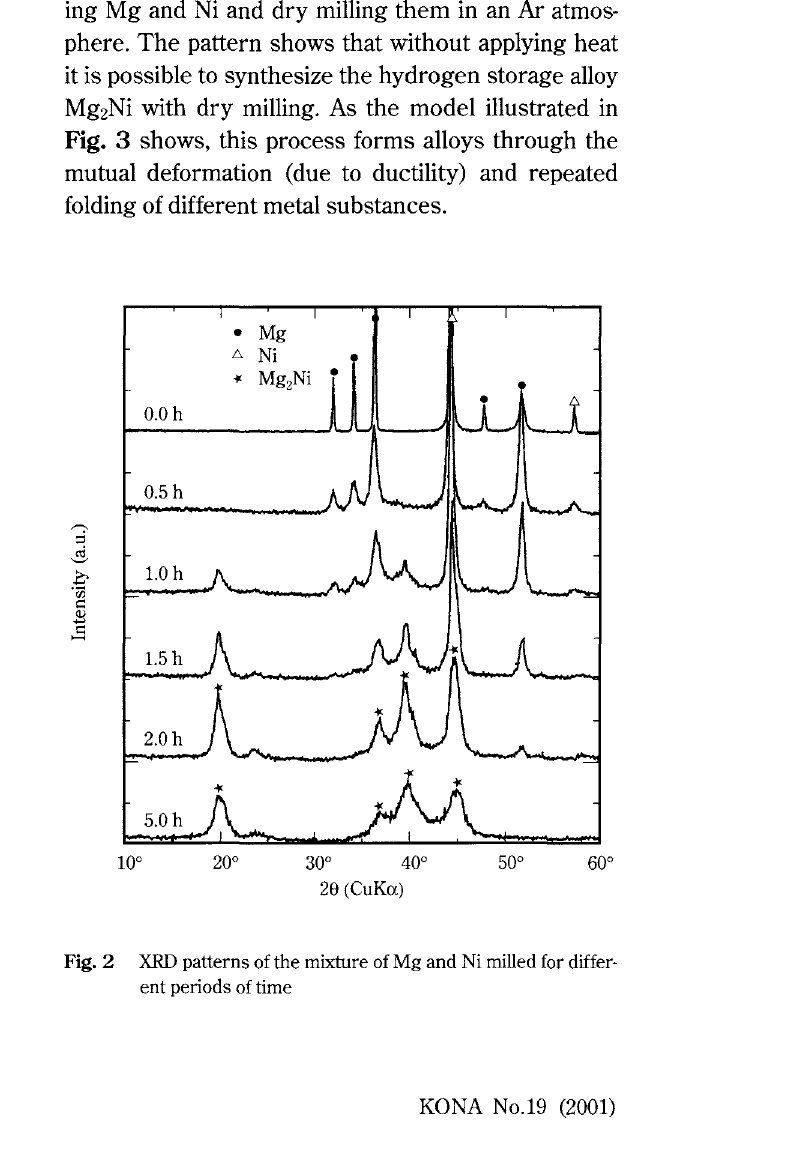
XRD patterns of the mixture of Mg and Ni milled for differ ent periods of time